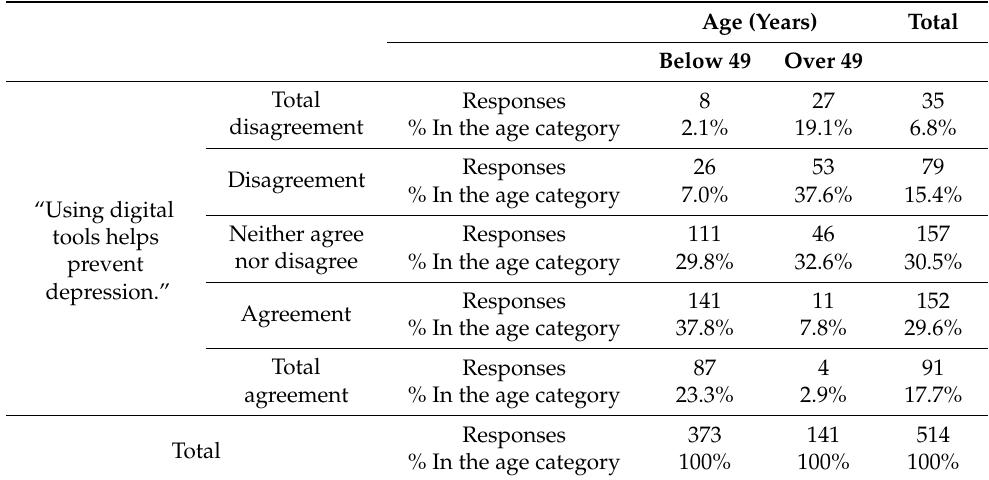
Table 7. Contingency table.